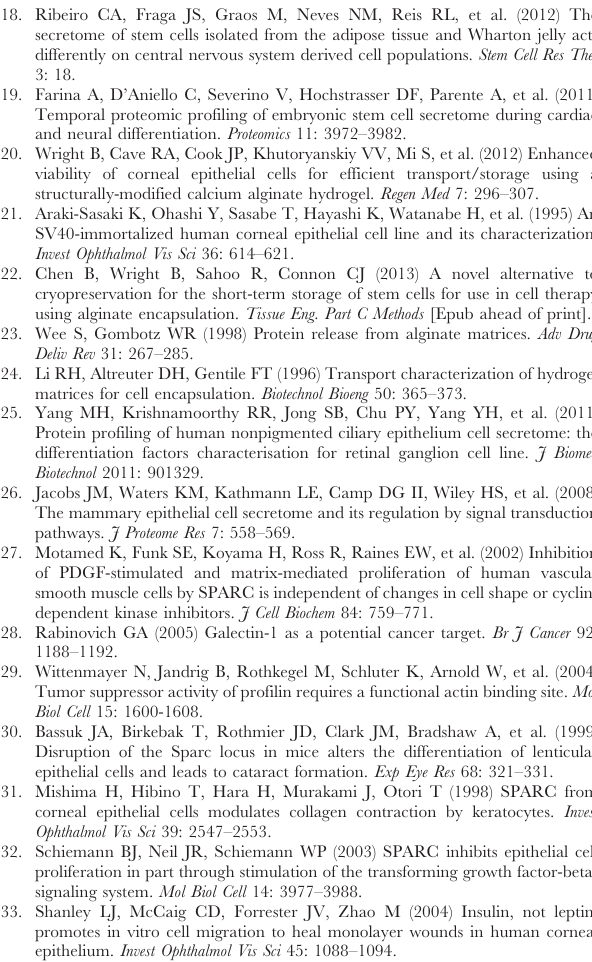
Table S1 Alginate gels adsorb proteins from CnT20 medium. Samples represent the mean (n =3 6 S.E.M.) amount of protein from supplemented and basal CnT20 medium and alginate gels suspended in those